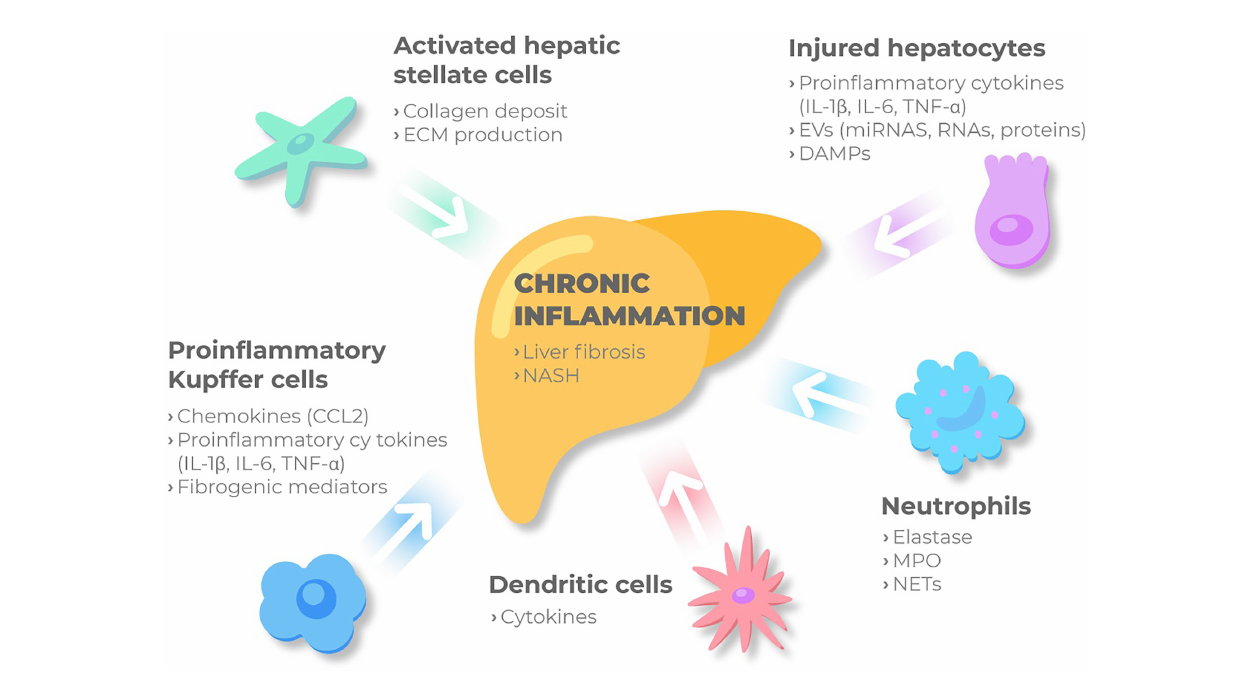
FIGURE 2 | Immune cellular network in MAFLD. Kupffer cells and MoMFs sense the accumulation of inadequate molecules and metabolites in the liver. Then, under these conditions the immune-active phenotype of the liver might be switched on, and KCs are activated releasing chemokines such as CCL2, pro-in fl ammatory cytokines and fi brogenic mediators. Besides, injured hepatocytes, mainly under metabolic stress, release proin fl ammatory cytokines, DAMPs and extracellular vesicles to perpetuate chronic in fl ammation through cell to cell communication. Monocytes and neutrophils are then recruited and activated contributing to in fl ammation by secreting NETs, elastase and myeloperoxidase. Liver macrophages recruit other immune cells and together with KCs bring out HSC from the quiescent status. Activated HSC will produce ECM and collagen deposit, ultimately promoting liver fi brosis. ECM, extracellular matrix; IL-1 b , interleukin 1 b ; IL-6, interleukin 6; TNF- a , tumor necrosis factor- a ; EVs, extracellular vesicles; miRNAs, microRNAs; DAMPs, damage-associated molecular patterns; CCL2, C-c motif chemokine ligand 2; NASH, non-alcoholic steatohepatitis; MPO, myeloperoxidase; NETs, Neutrophil extracellular